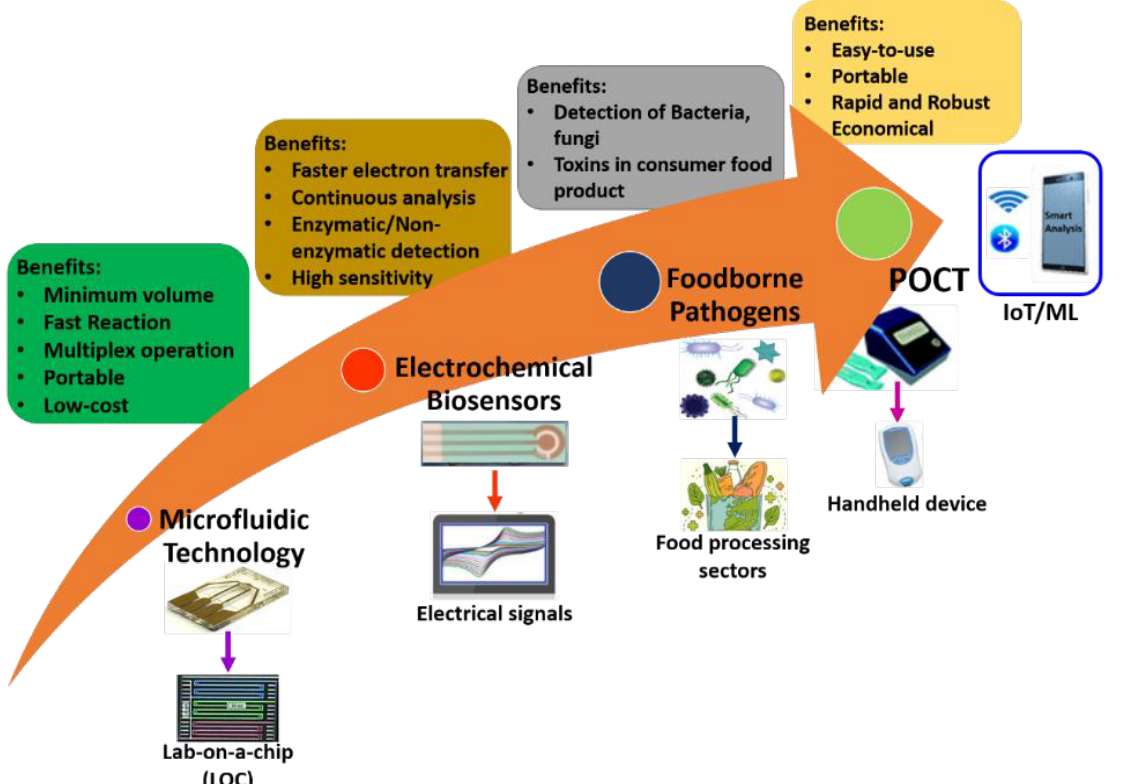
Figure 9. Future directions of microfluidic electrochemical biosensors within sustainable food safety applications.